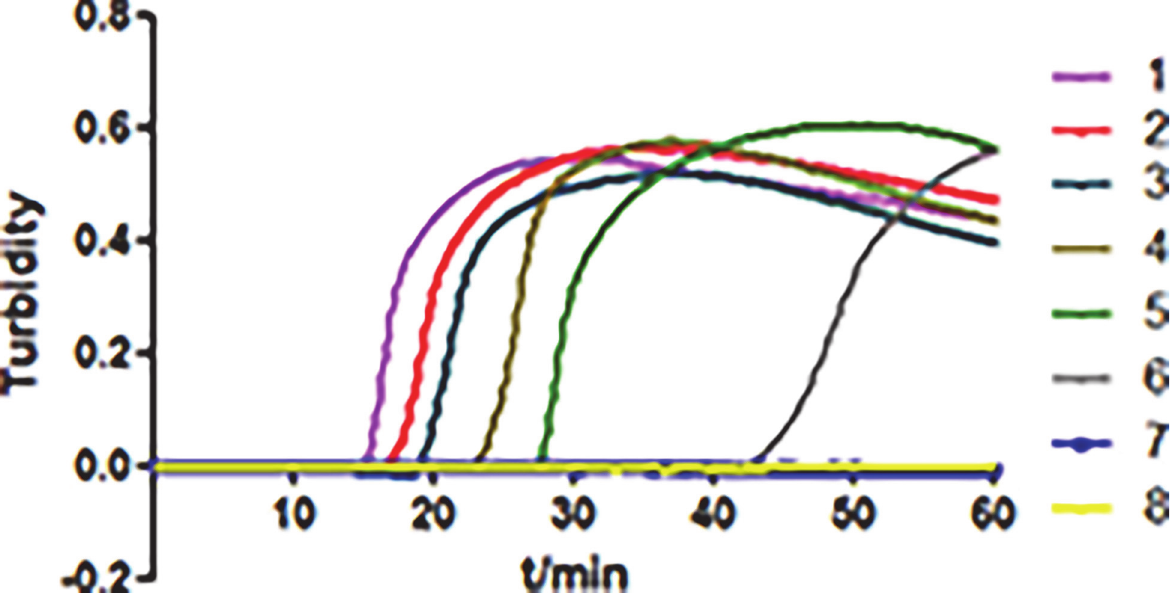
Fig 4. The sensitivity of the STY2879-LAMP assay in human simulated blood samples. The STY2879-LAMP was performed using simulated blood samples spiked with serially diluted S . Typhi strain CT18. The sensitivity of the STY2879-LAMP assay was monitored by a real-time measurement of turbidity. The corresponding curves of decreasing concentrations of CT18 are shown from sample 1 to 7 (1 – 7: from 2×10 6 – 2× 10 0 CFU/mL); 8 is the negative